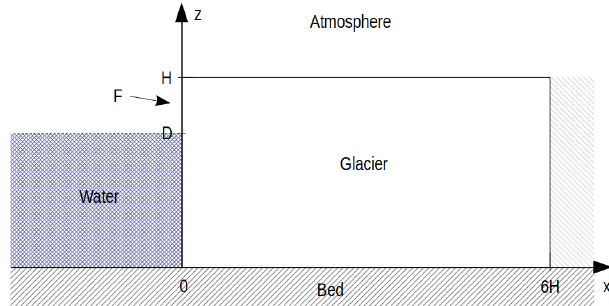
Figure 1. Geometrical setup of the stress computation: two- dimensional plane, flat glacier frozen to the bedrock with a calving front at its terminus. The glacier length L is 6 times as large as the glacier height H in order to ensure that the boundary condition on the right does not significantly influence the stress field at the termi- nus on the left. The ice thickness is denoted H , ice thickness below the water level is D and the free-board is denoted F